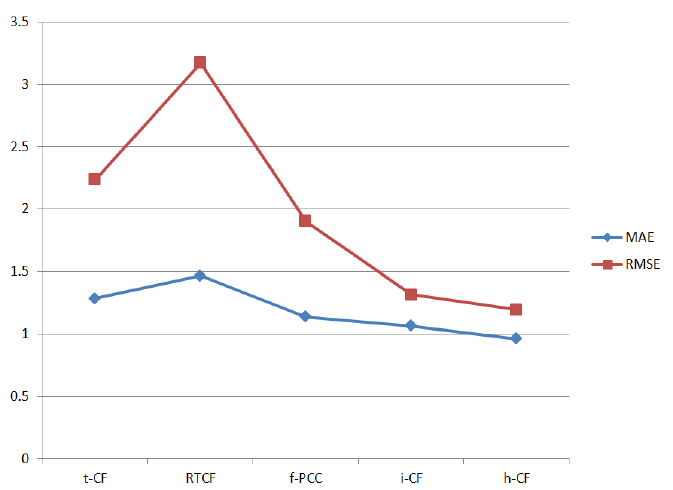
Figure 6. Average values of MAE and RMSE in five methods based on the same 58 group target users.